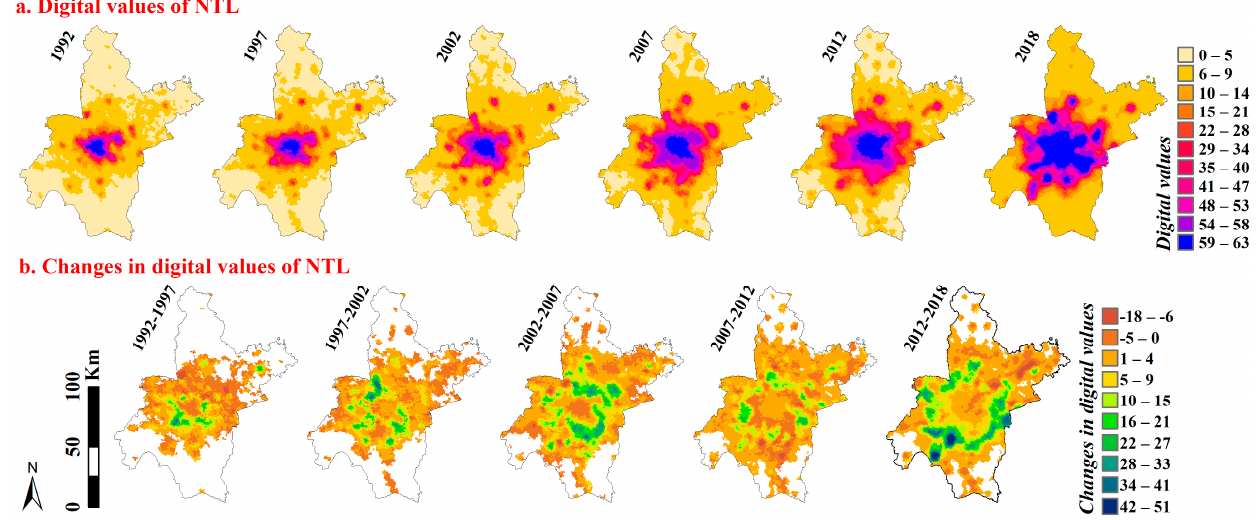
Figure 4. ( a , b ) Spatiotemporal pattern of nighttime light and its changes at five-year intervals during 1992–2018 in a representative city,